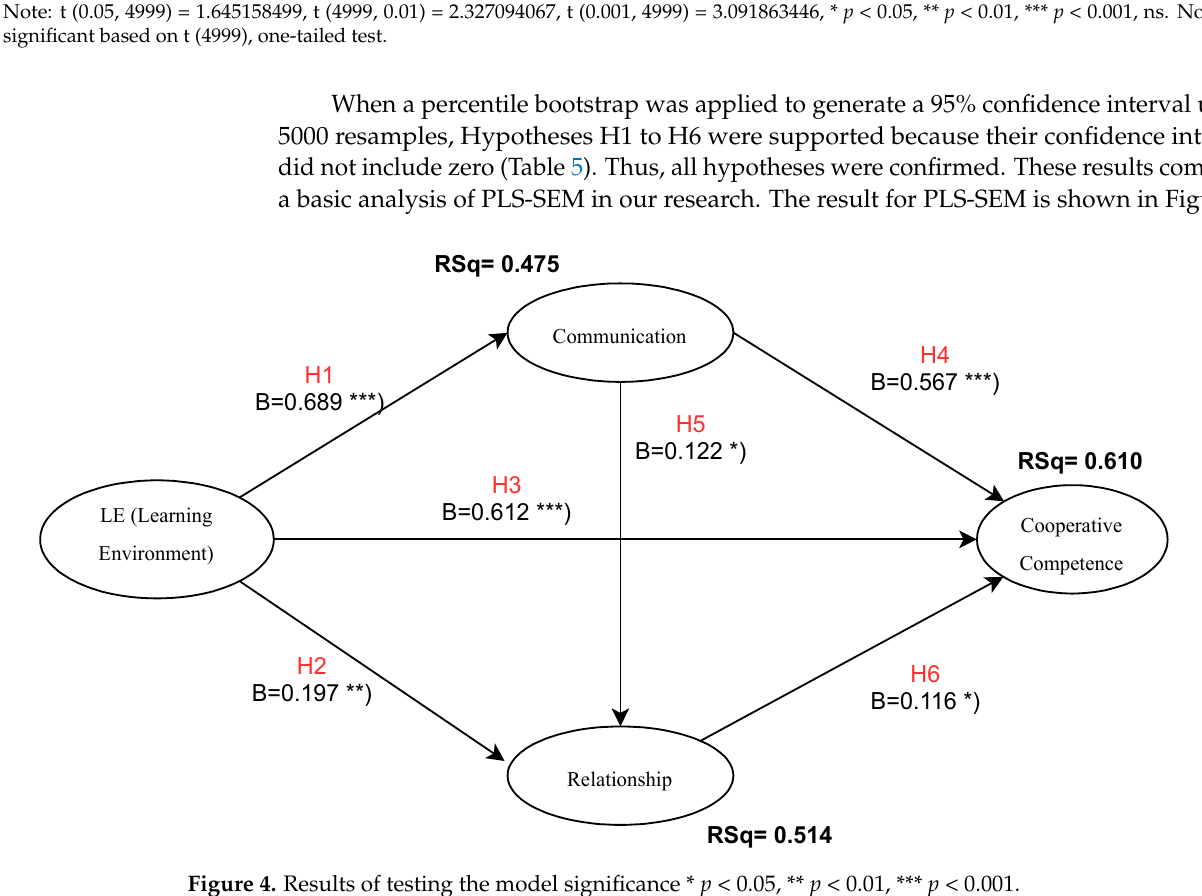
Figure 4. Results of testing the model significance * p < 0.05, ** p < 0.01, *** p < 0.001.